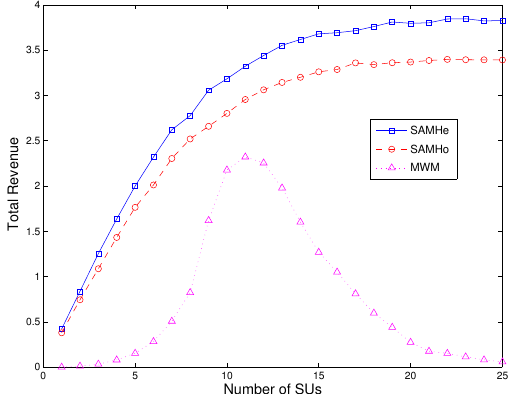
Figure 3: Total revenue obtained by the PO. Both SAM methods are able to increase the revenue until flattening from 15 SUs onwards. MWM starts at a low value, achieves its maximum at 11 SUs and then starts dropping for higher SU